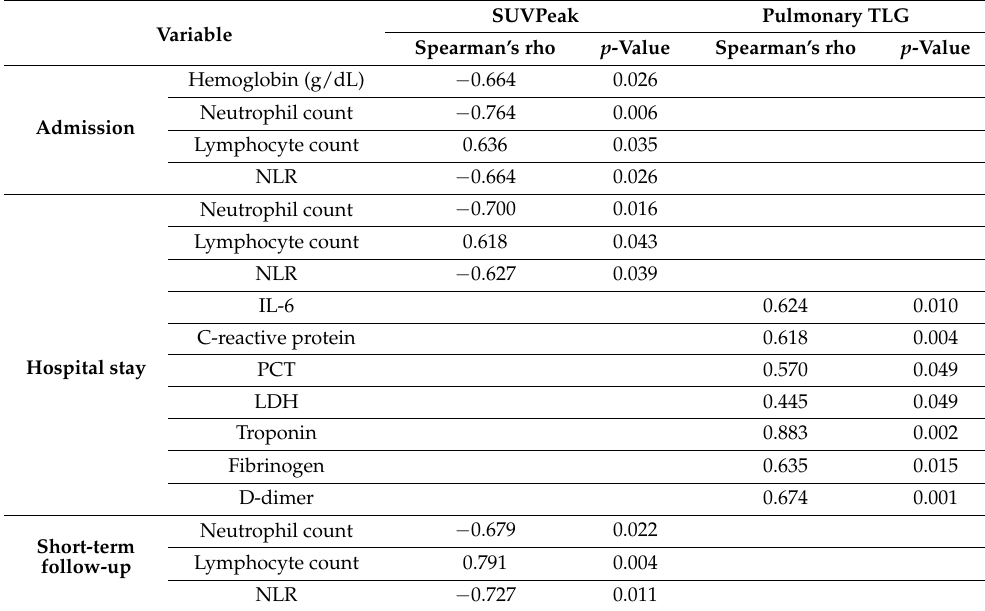
Table 2. Bivariate correlations of volumetric [ 18 F]FDG PET/CT parameters with laboratory